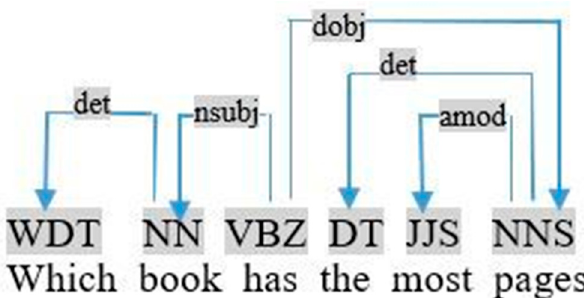
Figure 17. Graph dependency of the query «which book has the most pages».